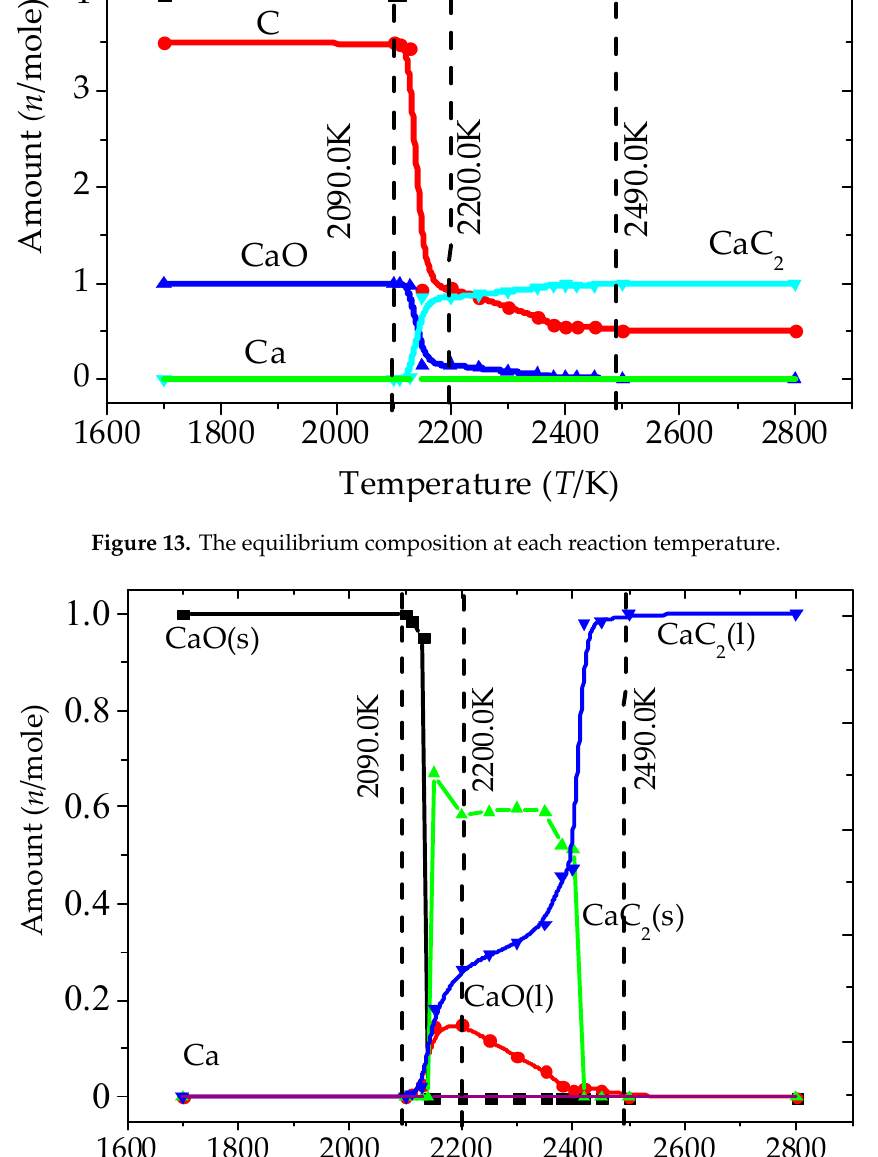
Figure 14. The equilibrium phase composition at each reaction temperature.